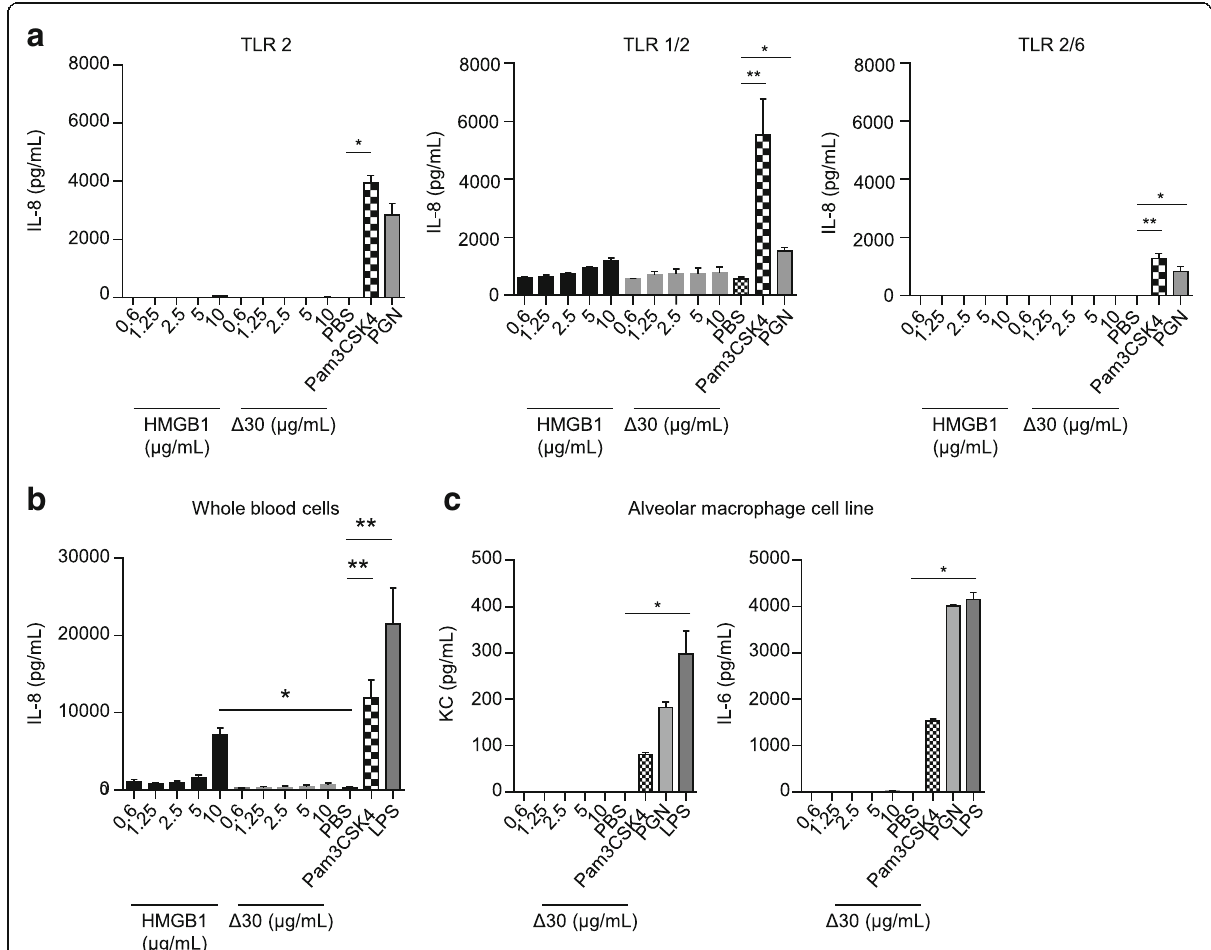
Fig. 2 Pure C-tail truncated HMGB1 ( Δ 30) does not mediate cytokine production in vitro. HMGB1 and Δ 30 were added at the indicated concentrations to a ) HEK cells transfected with functional TLR 2, 1/2 and 2/6 dimers, b ) whole blood collected from healthy volunteers and c ) alveolar macrophage cells. Serum cytokine levels were quantified by ELISA after 24 h. PGN (2.5 μ g/mL) and Pam3CSK4 (2.5 μ g/mL), known TLR2 ligands, were included as positive controls. LPS (100 ng/mL) was included as a TLR4 positive control. ( a =representative data from 1/3 experiments; b =combined data from 5 individual donors; c =1 experiment performed in triplicate